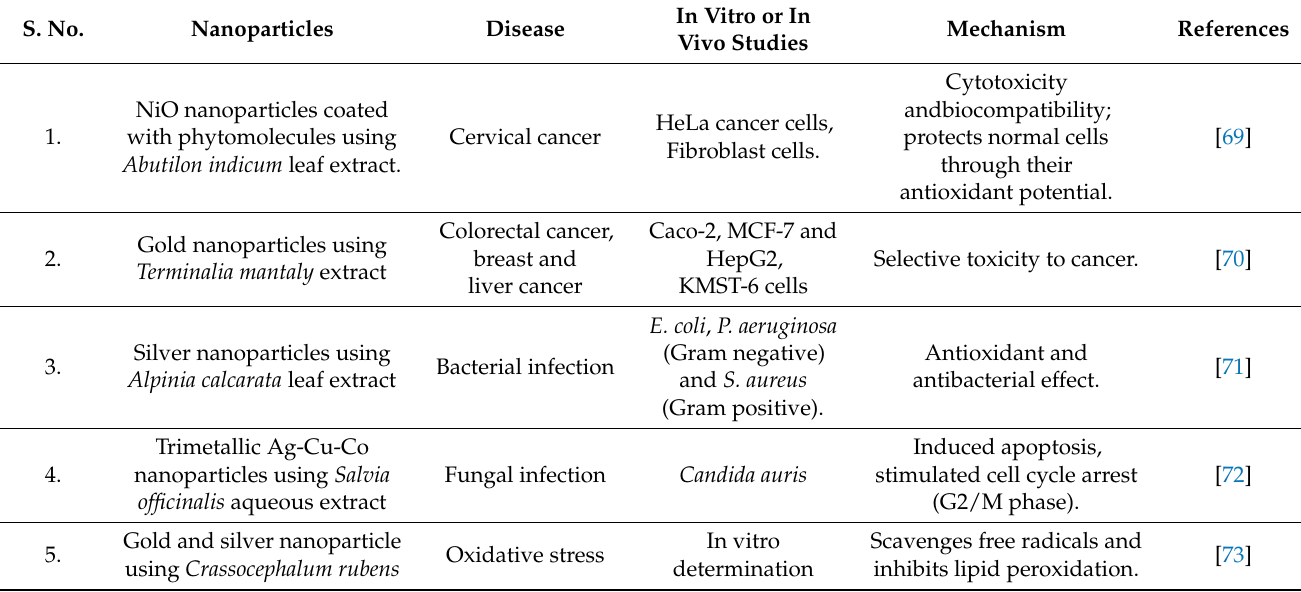
Table 1. Phytochemical-coated nanoparticles in various